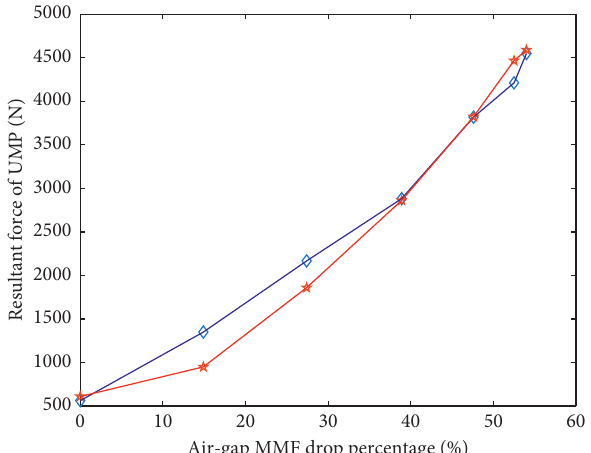
Figure 4: The diagram of UMP trend under the change of air-gap